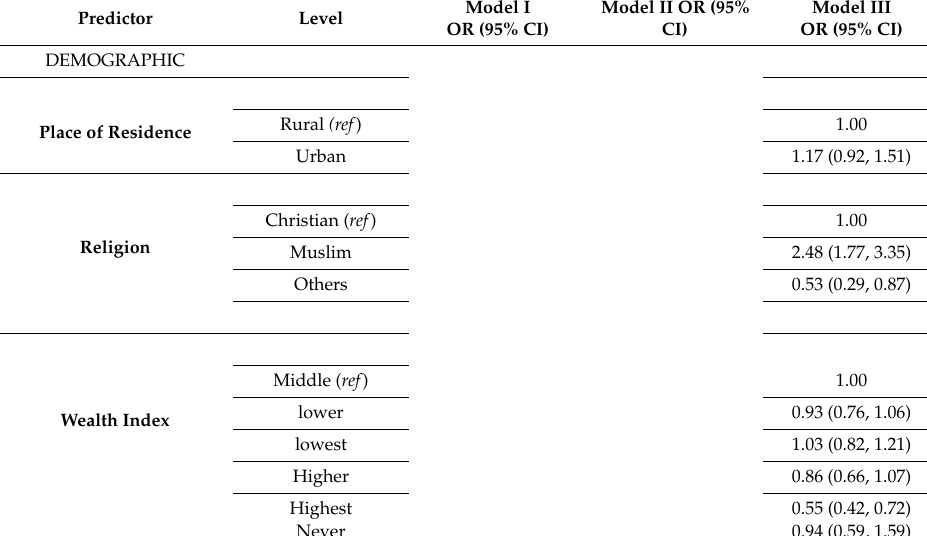
Table A3. Unadjusted and adjusted posterior odds ratios (POR) and associated 95% credible region (CR) of circumcision of Girls ages 0–14 across selected covariates (Kenya, DHS 2003–2014 combined) from Bayesian Geo-additive